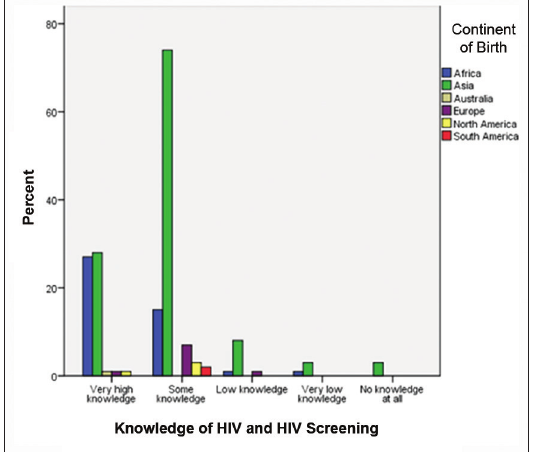
Figure 2: Assessment of general knowledge of HIV by continents